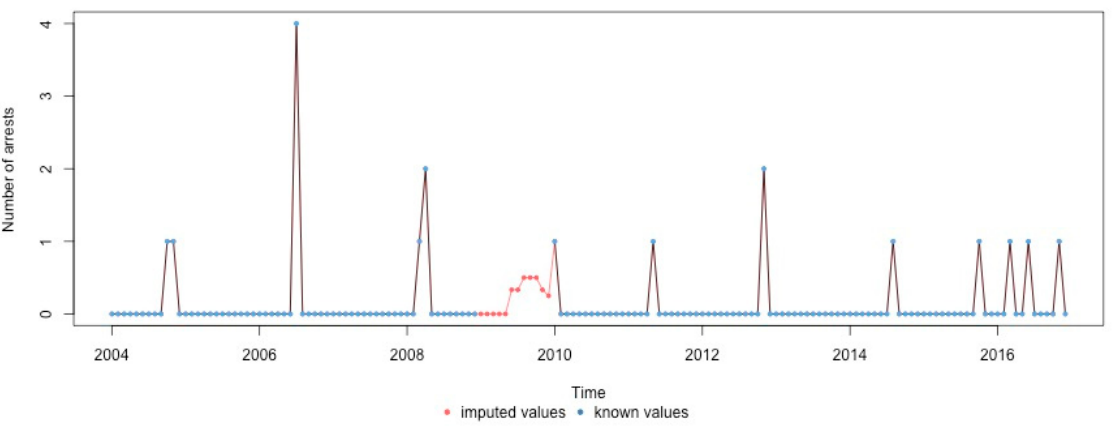
Figure A15. Methamphetamine-related organized neighboring countries nationals crime arrests 2004–2016 in the Czech Republic – imputed missing values.